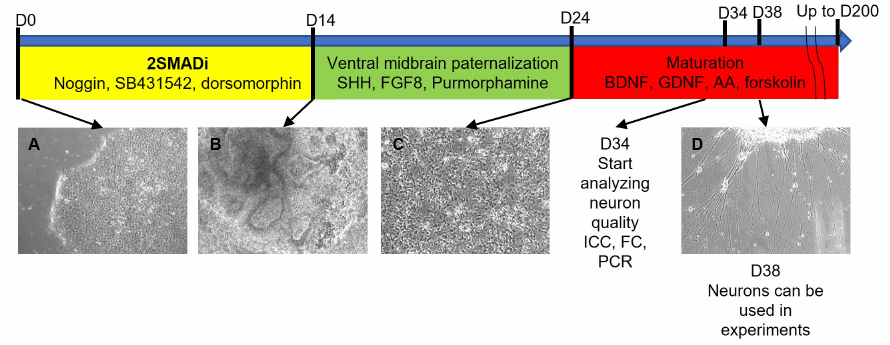
Figure 1. DAns differentiation protocol scheme. ( A )—undifferentiated iPSCs in mTeSR1 media on Matrigel (differentiation day 0); ( B )—common neural progenitors at the end of the first differentiation step (differentiation day 14); ( C )—ventral midbrain neuronal progenitors at the end the second differentiation step (differentiation day 24); ( D )—mature neurons at the third differentiation step (differentiation day 38). Magnification 100 ×